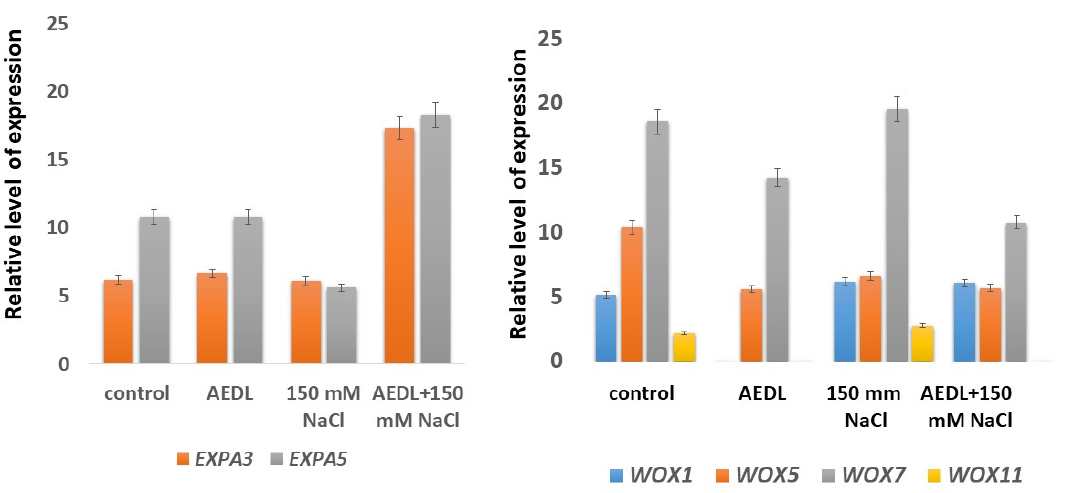
Figure 6. Relative expression levels of genes of EXPA3 and EXPA5 ( left ) and WOX family ( right ) in tobacco seedling roots. Standard deviations are shown according to Student’s criterion, p < 0.05.